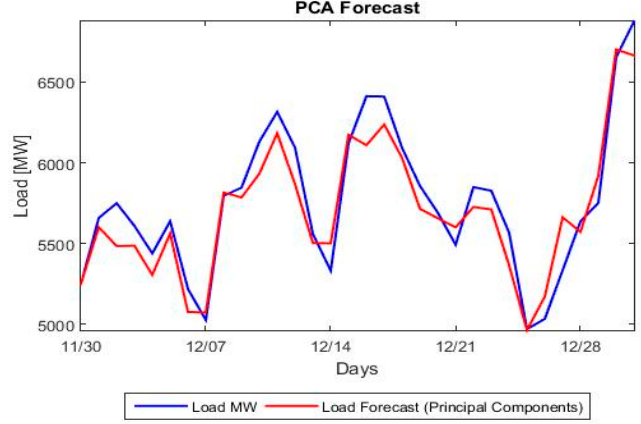
Figure 18. Principal component regression forecast for December 2014.